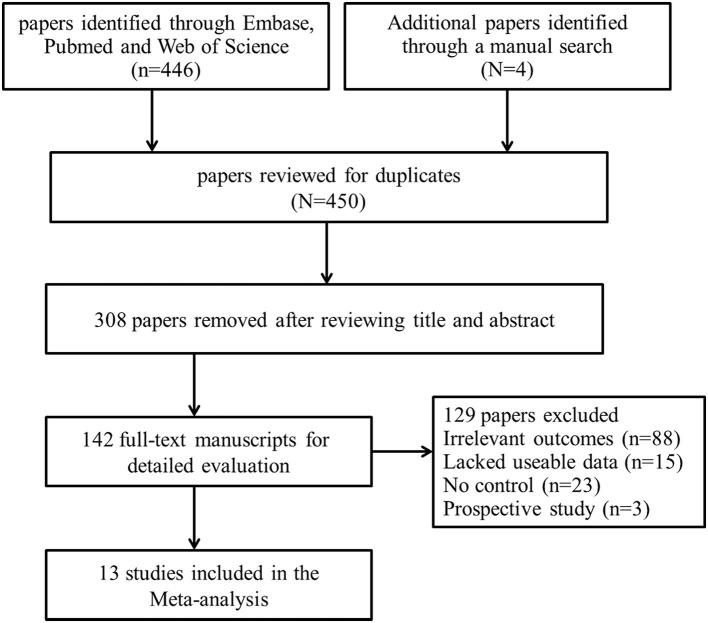
Flow chart of study selection in the meta-analysis.